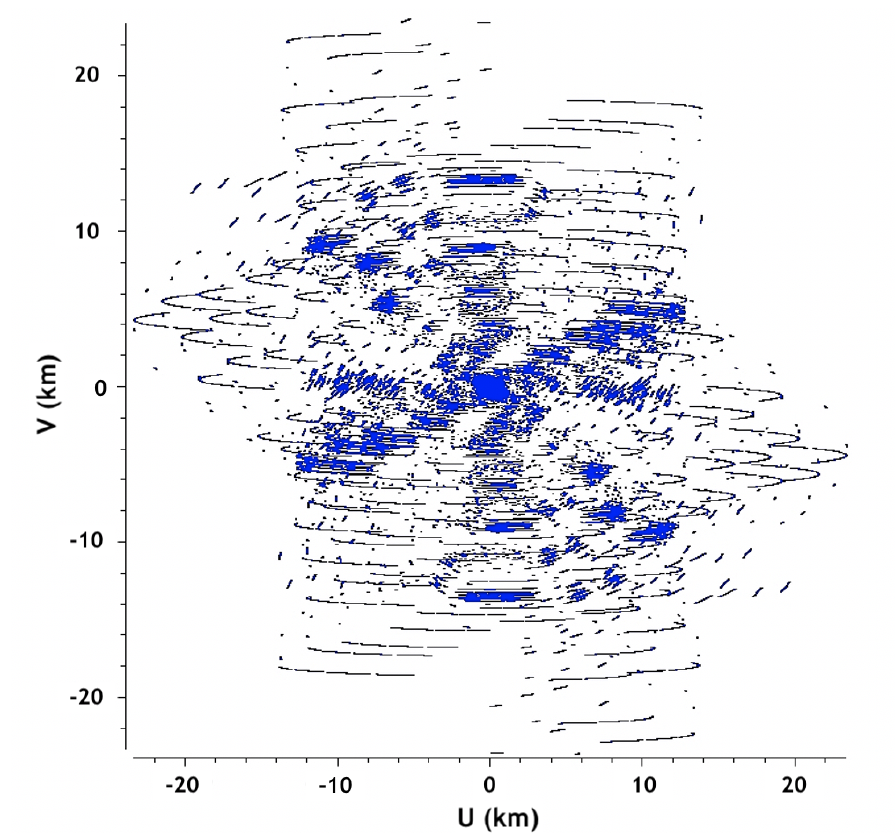
Figure 4. GMRT uv coverage for J0034. Despite the 4 h on-source and the 200 MHz of band- width, the equatorial declination results in sparse uv − coverage which reduces the effectiveness of aperture